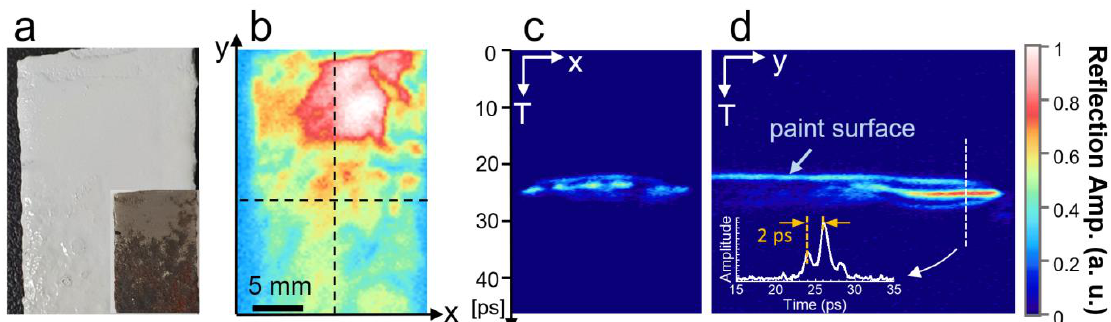
Figure 2. ( a ) Photograph of rusted metal concealed by paint. ( b ) Time-integrated C-scan image (in terms of envelope function) for ( a ). ( c , d ) Cross-sectional B-scan images along with the x -axis and y -axis taken from ( b ). (See dashed lines in ( b )). Inset shows A-scan plot (i.e., THz amplitude vs. time-delay) obtained along the dashed line.